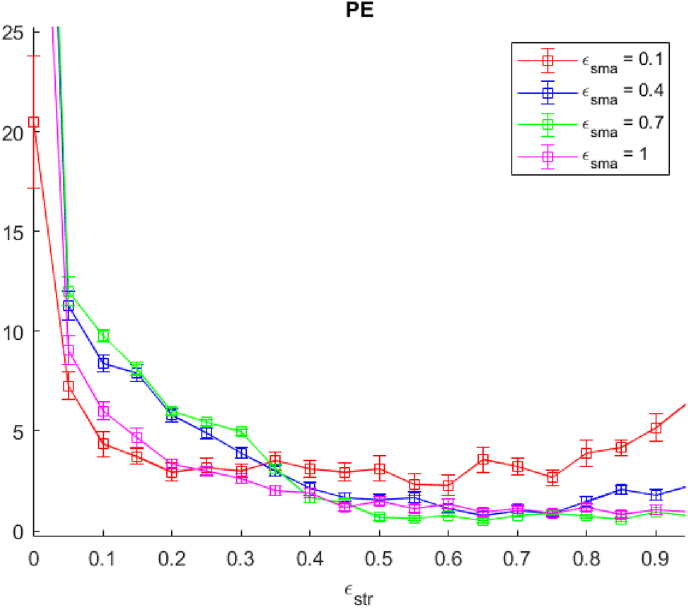
Perseverative Errors as a function of εstr, for four different values of εsma. Note that perseverative errors are largely constant except at low values of εsma or when both εsma approaches 1 and εstr approaches 0. Error bars show one standard error from the mean.